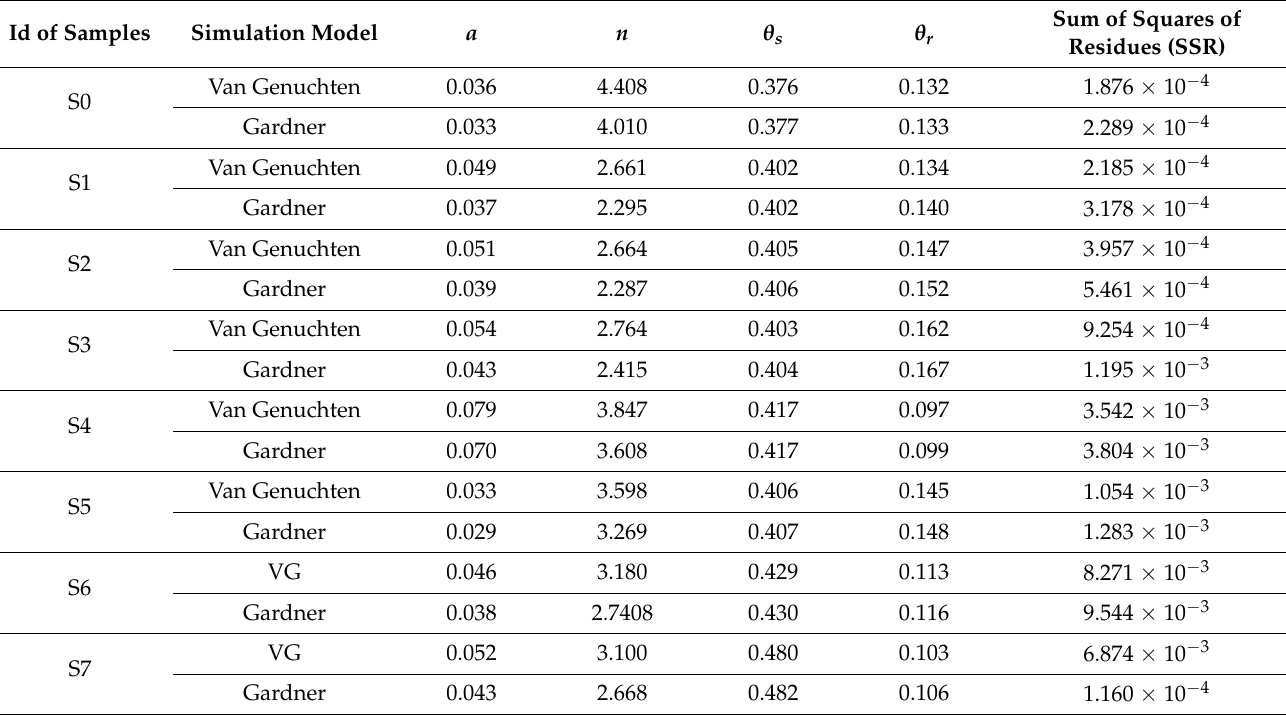
Figure 12. Experimental data and simulated SWCC of loess samples with different dry densities. Table 5. SWCC parameter simulation and accuracy test ( α =